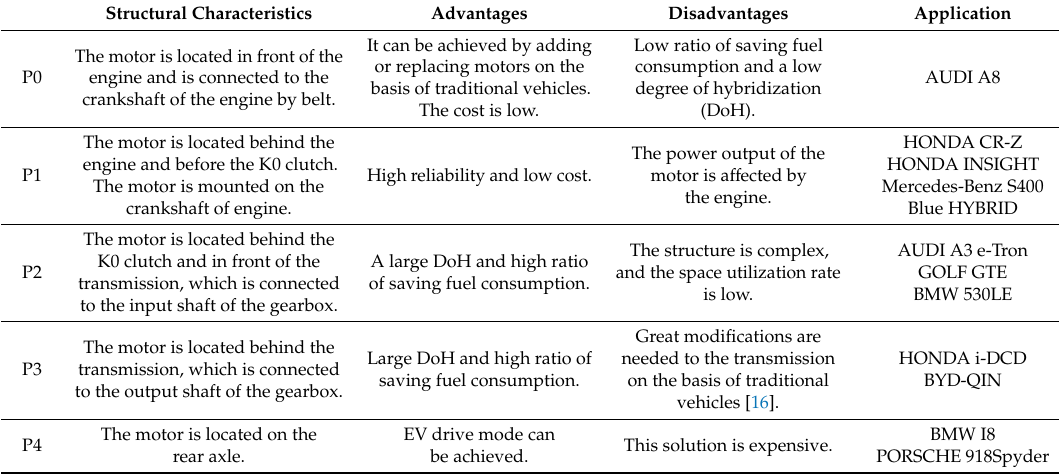
Figure 2. Topological diagrams of various powertrains. Table 2. A summary of the configurations of